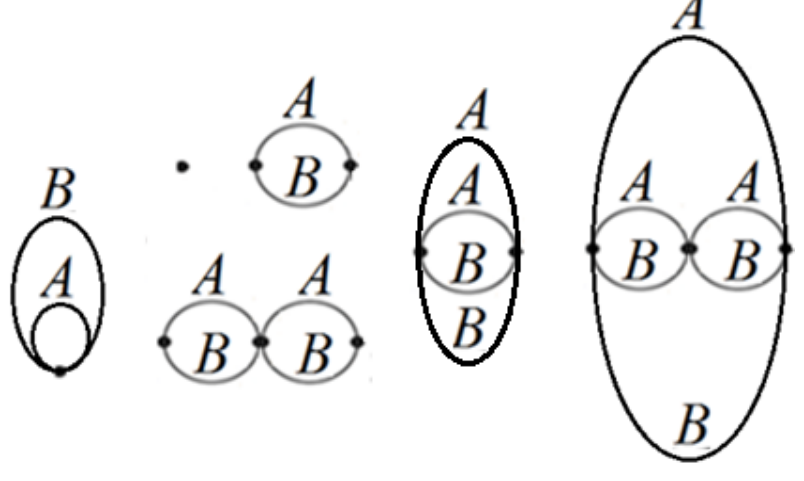
Figure 4. Cases of a ch-final form of the graph A * B .